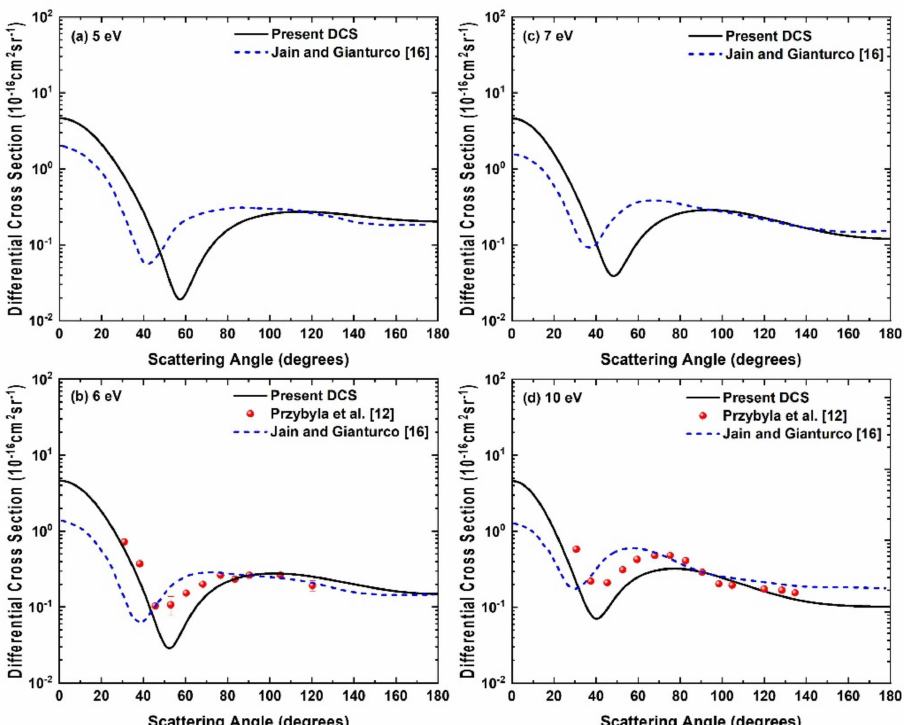
Figure 2. Differential cross sections for positron-CH 4 elastic scattering at incident positron energies ( a ) 5 eV, ( b ) 6 eV, ( c ) 7 eV and ( d ) 10 eV. Solid line, present DCS; dashed line, Jain and Gianturco [16]; solid sphere with error bars, Przybyla et al.